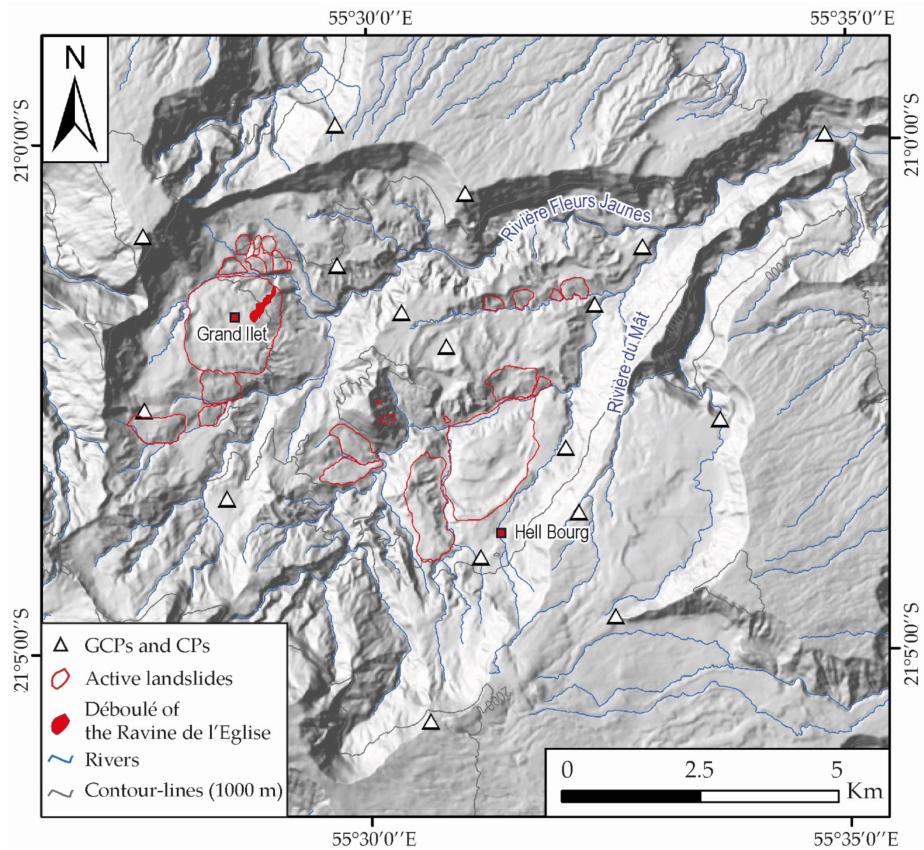
Figure 3. Localization of the control points used to build the 1978 and 1984 DSM and orthopho- tographs of the Cirque of Salazie. Most of the plateaus are occupied by active landslides [6,7,46]. GCPs: ground control points; CP: check